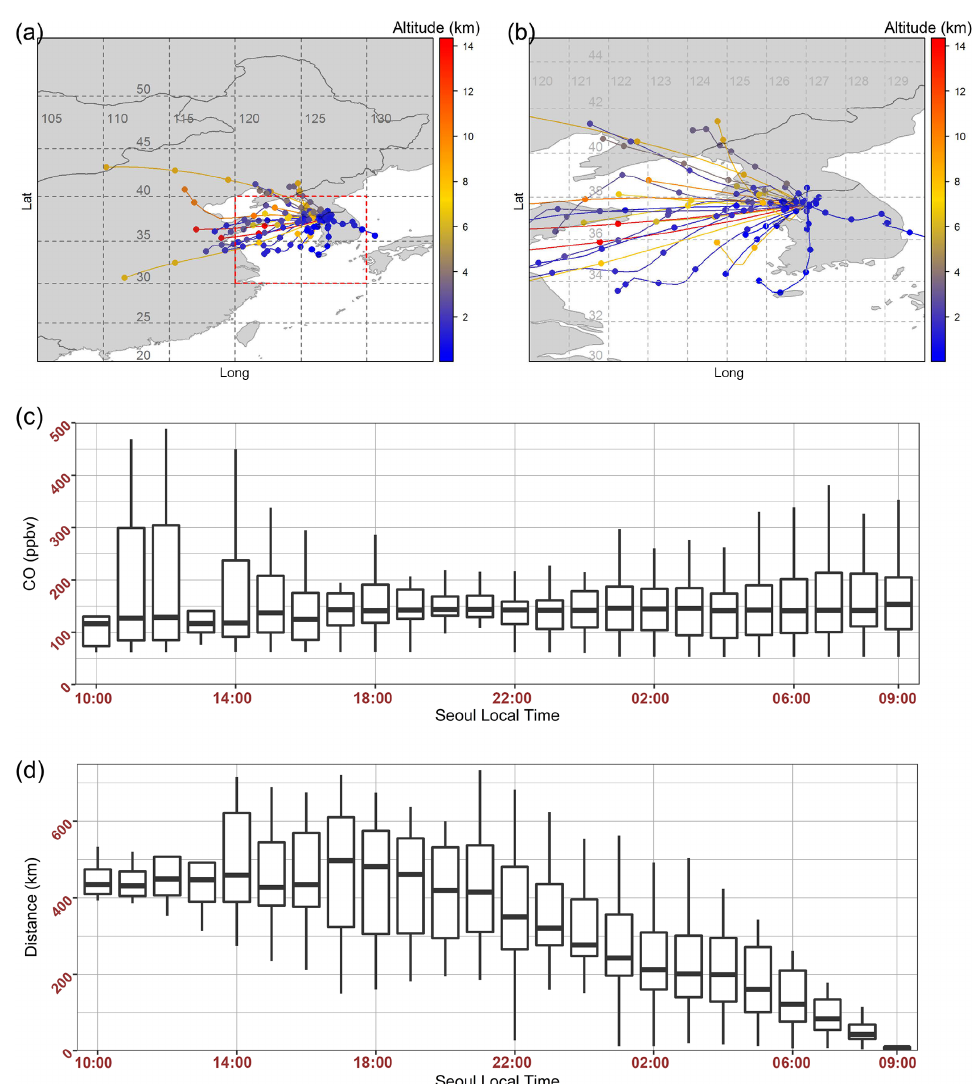
Figure 8. C-TRAIL output for the dynamic weather period (DWP) for Seoul as the receptor: (a) 24h trajectories of packets for the entire domain, (b) 24h trajectories of packets for the zoomed area in South Korea, (c) boxplots of the CO concentrations of all packets at each hour before they reached Seoul, and (d) boxplots of packet distances from Seoul at each hour before the packets reached